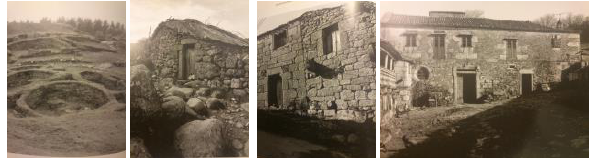
Figure 1. Evolutionary sequence of Galician